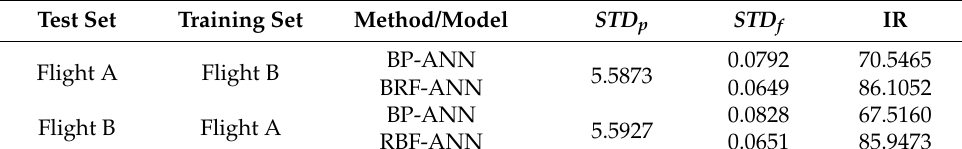
Table 1. Comparison of compensation results of BP-ANN and BRF-ANN.